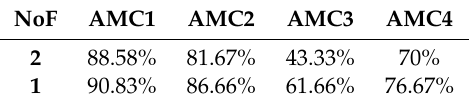
Table 7. Effect of GA-based feature selection on the proposed MLP using HLN = 30 for AMC phase.